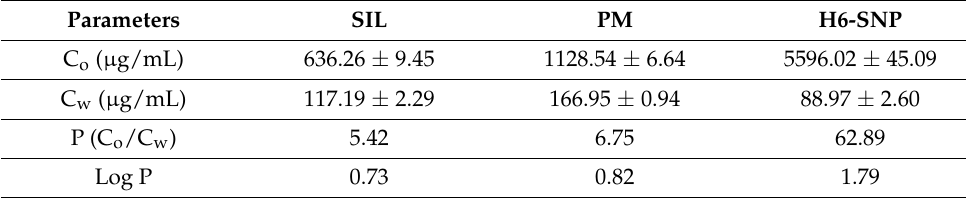
Table 7. Partition coefficient of SIL, PM and H6-SNP.